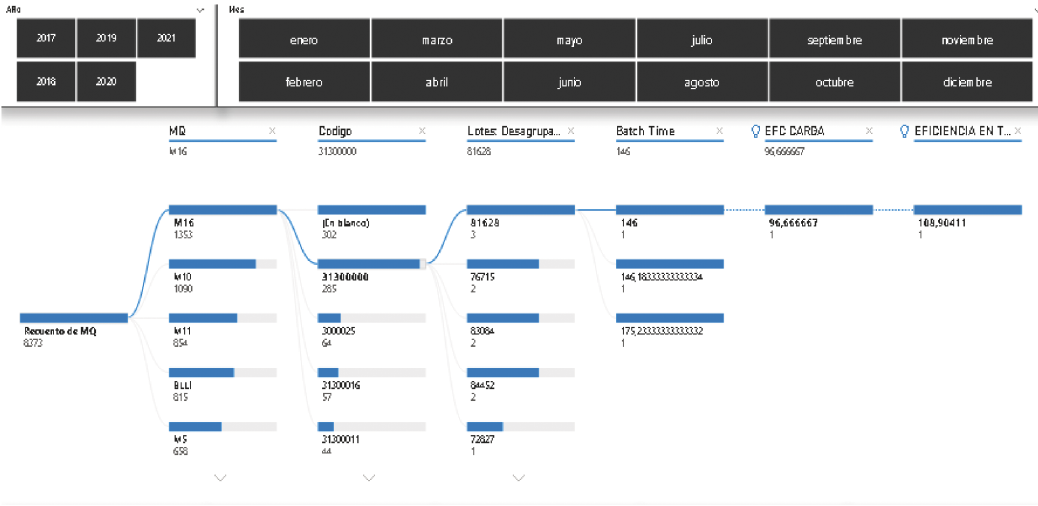
Figure 13. Traceability of production by